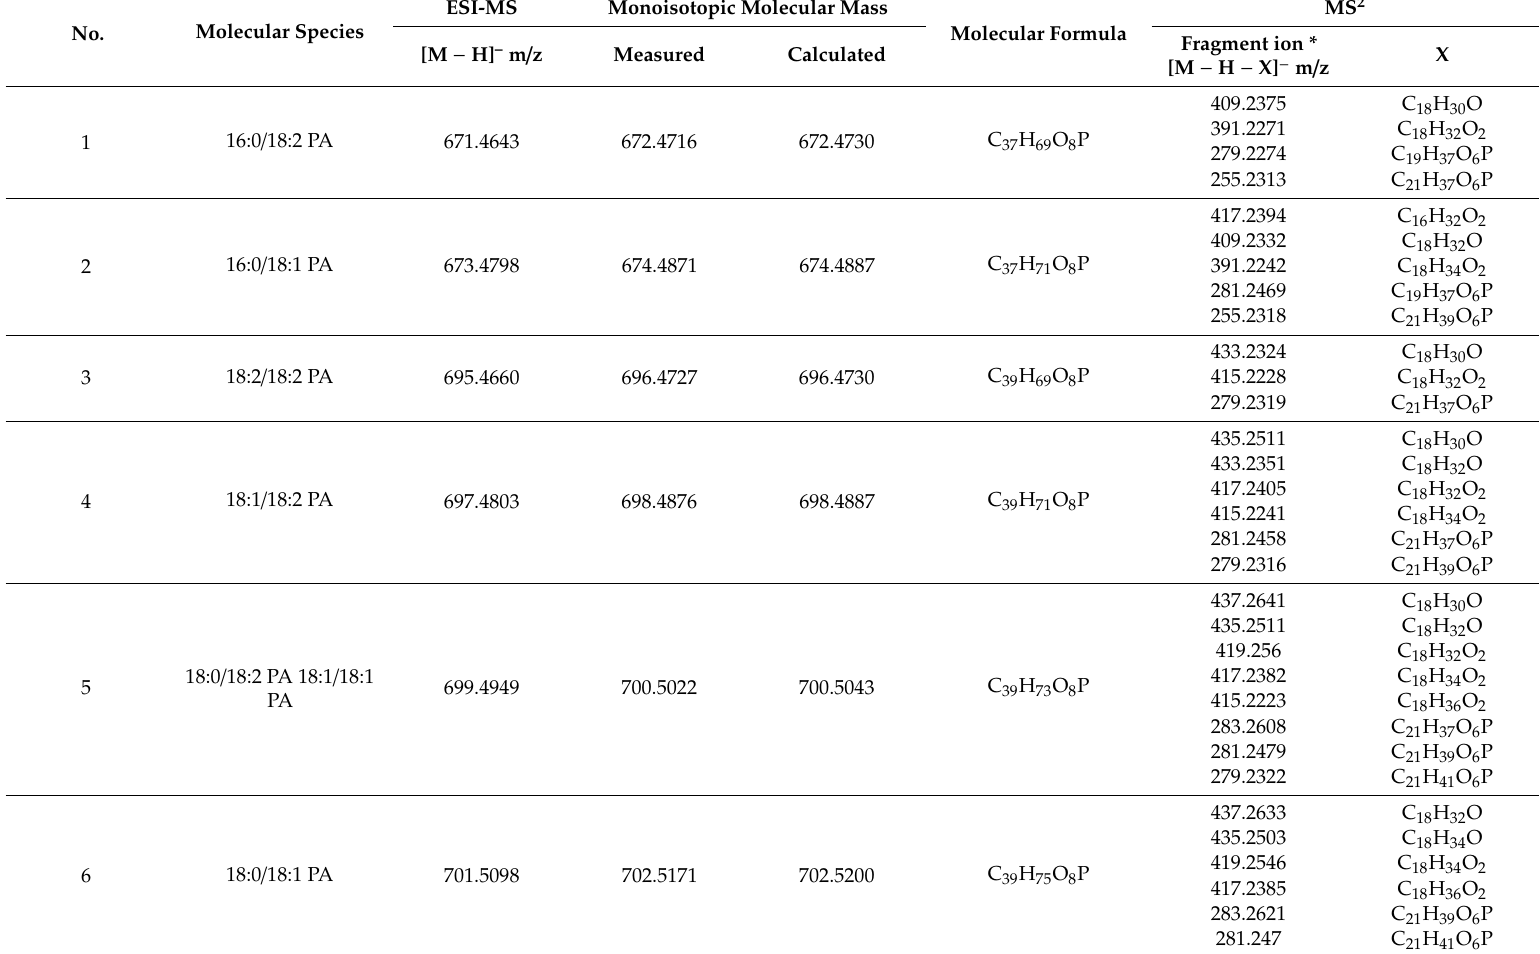
Table 7. Molecular species of phosphatidic acid (PA) from Madhuca ellitica